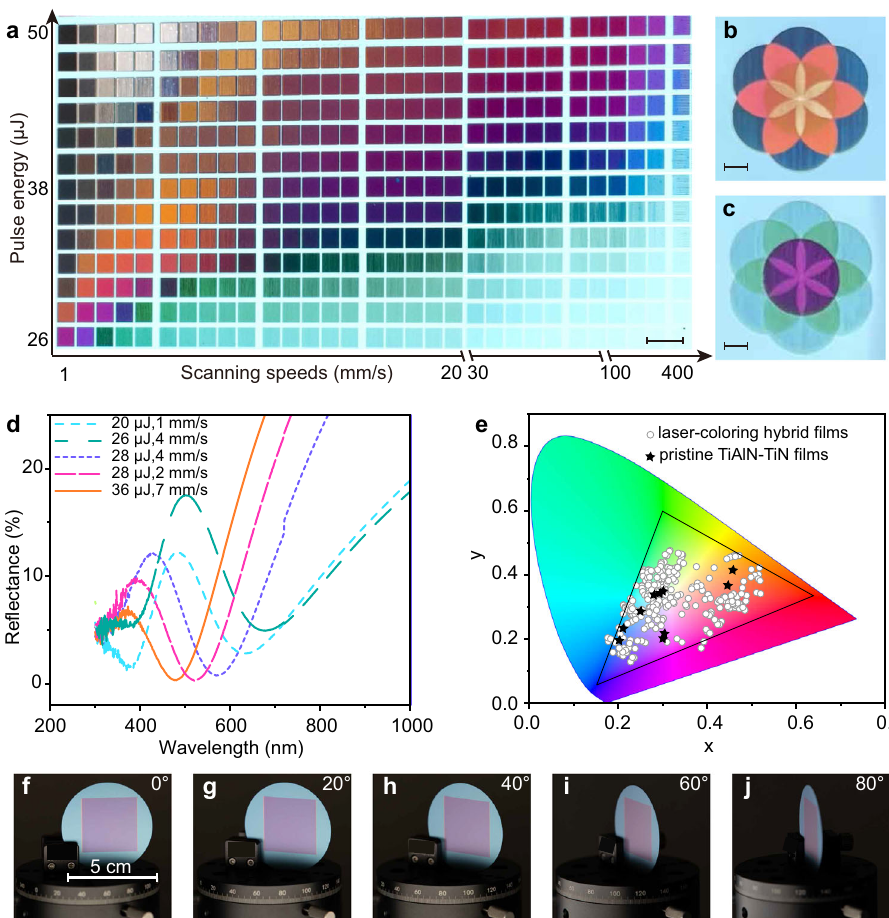
Fig. 3 | Optical properties of laser-printed colors on TiAlN – TiN hybrid fi lms. a Matrix palettes produced with various pulse energies and scanning speeds. The thickness of TiAlN and TiN are 60nm and 50nm, respectively. b , c Seven circles that are independently written. The colors in the overlapping areas are changed, indicating that the colors are rewritable. The scale bars are 5mm. d Near-normal